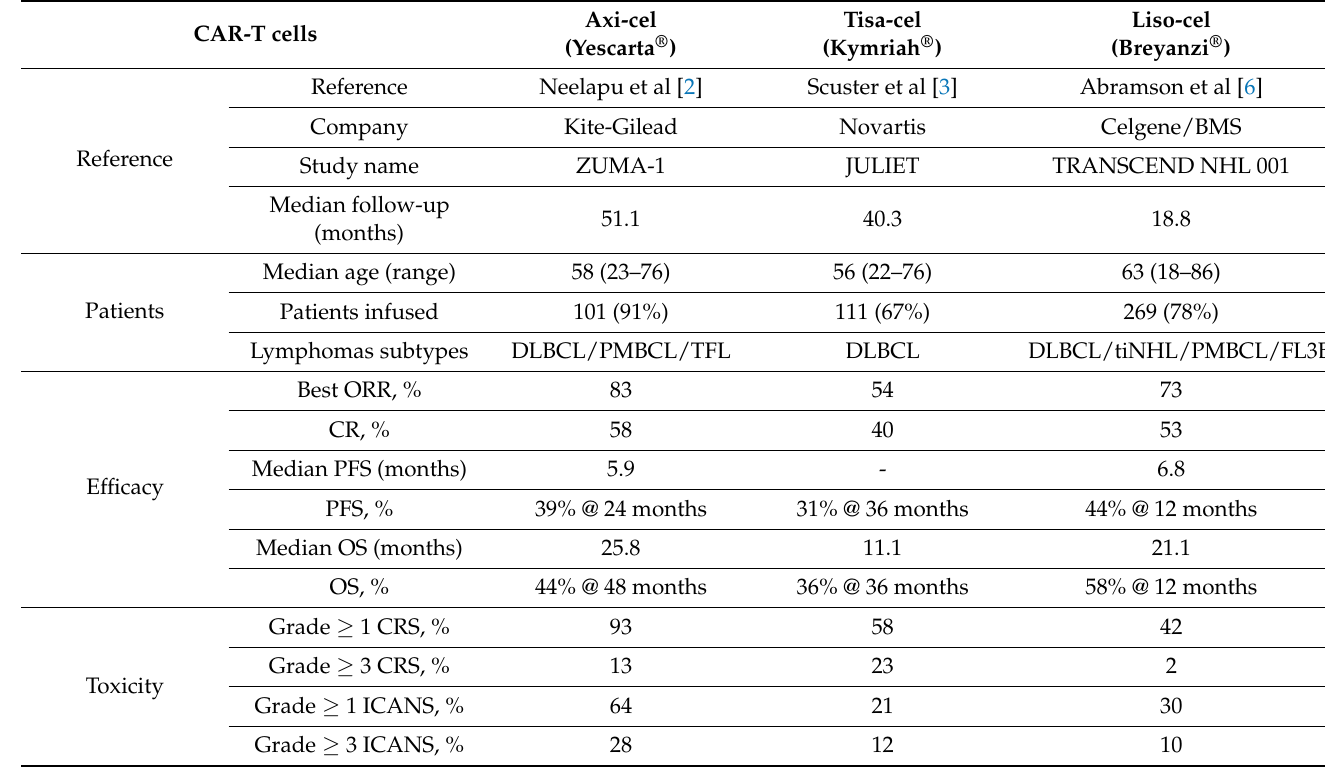
Table 2. Updated CAR T-cells Pivotal Studies in